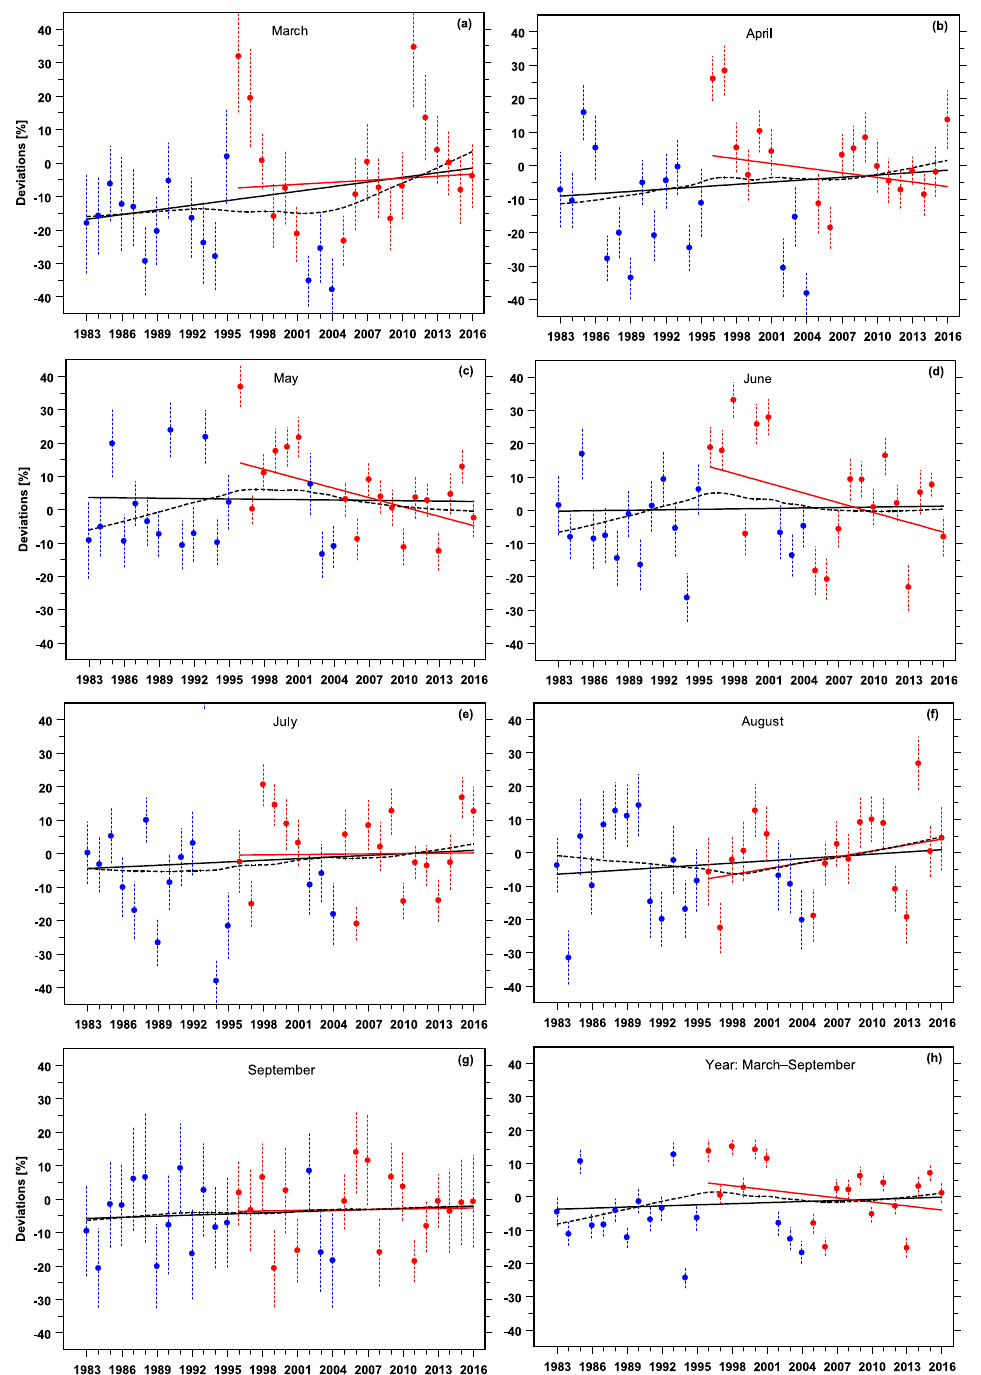
Figure 6. Time series of normalized deviations of monthly means of daily doses and normalized yearly sum of daily doses: observed values (red circles) and reconstructed values (blue circles). Vertical lines show ± 1 standard deviation. Straight lines represent linear regression line. Dashed curves represent smoothed values by LOWES smoother (Cleveland,